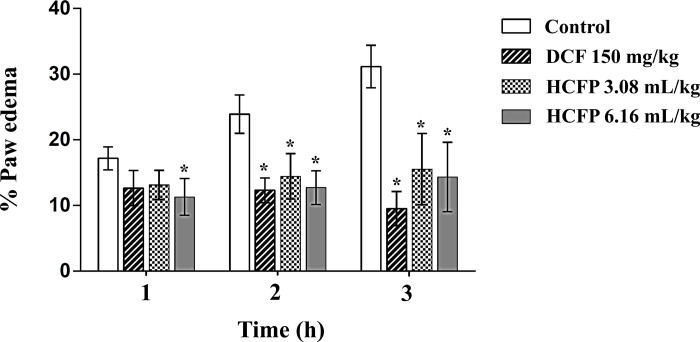
Effect of HCFP and DCF on carrageenan-induced paw edema in Wistar rats.Bar graphs show percentages of changes in paw edema. Data are expressed as mean ± SD of n = 6 rats/group. Asterisk “*” indicates a significant difference at p < 0.05 as compared with the control group.